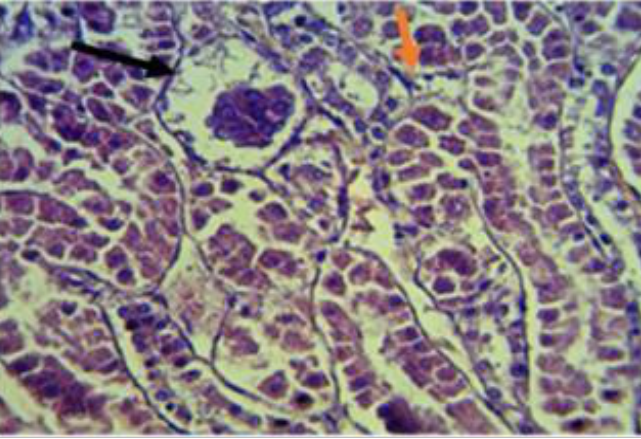
Figure 13. Histopathological section of kidney of chicken shows atrophy of glomerular tufts ( ) with vacuolation of tubular epithelia